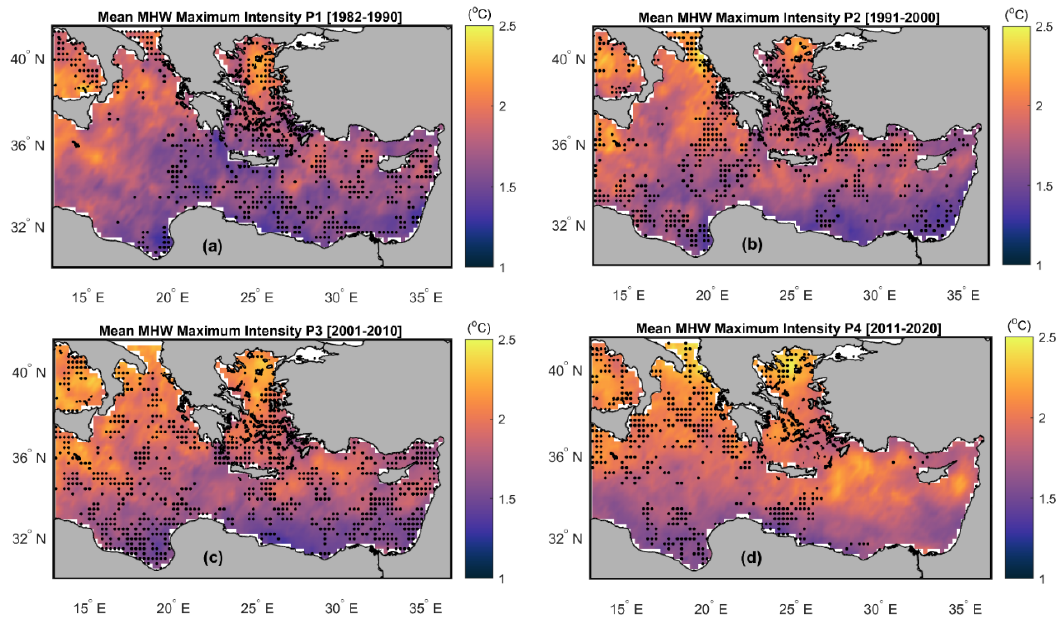
Figure 10. The EMED MHWs i max (°C) for ( a ) P 1 (1982–1990), ( b ) P 2 (1991–2000), ( c ) P 3 (2001–2010) and ( d ) P 4 (2011–2020), and the black dots indicate the change is not significantly different ( p > 0.05).